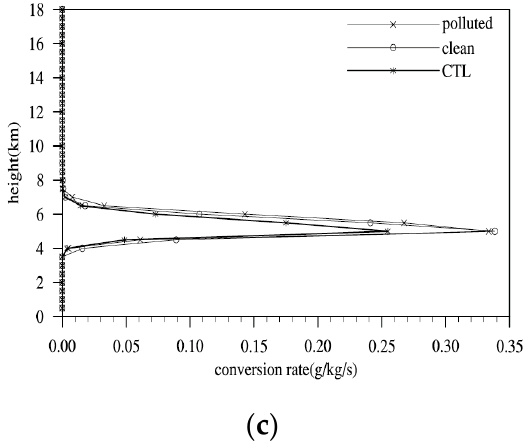
Figure 9. ( a ) The mixing ratio of graupel (g kg − 1 ), and the conversion rates of ( b ) the deposition of water vapor into graupel, and ( c ) the accretion of rain by graupel (10 − 4 g kg − 1 s − 1 ).